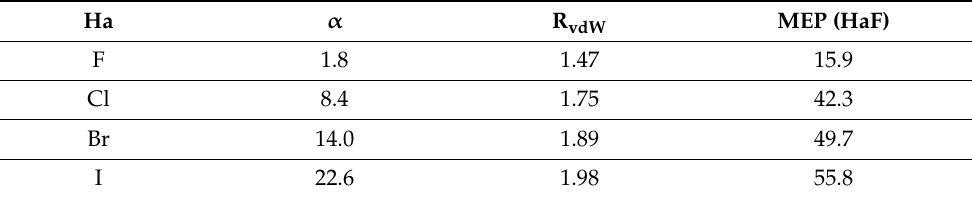
Table 7. Atomic polarizabilities ( α , a.u.) of halogen (Ha) elements, van der Waals radii (in A,) and σ –hole MEP values (in kcal/mol) of their tetrafluoride derivatives taken from ref [63]. Ha α R vdW